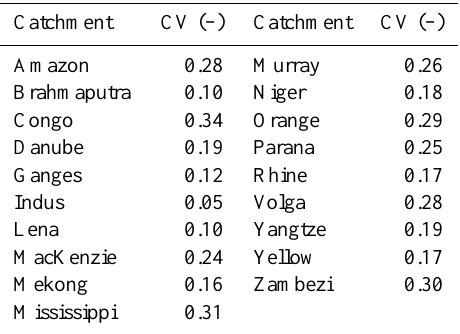
Table 3. Catchment specific coefficients of variation (CV) derived from long-term annual average modeled discharge for measurement stations closest to the catchment outlets, obtained with PET time se- ries calculated with the six different potential evaporation